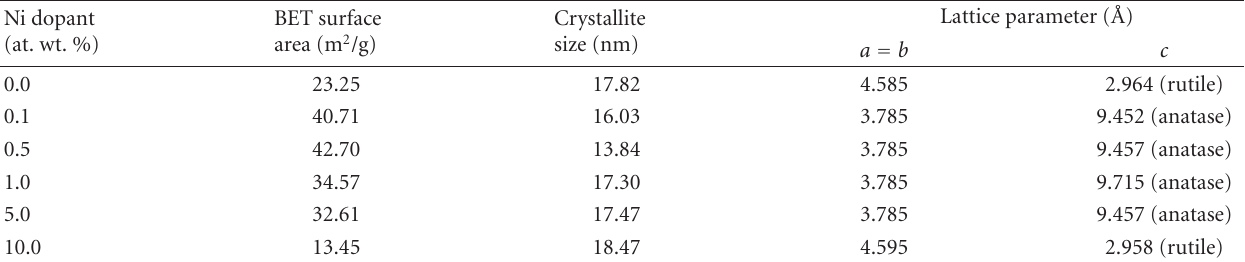
BET surface area (m 2 /g)